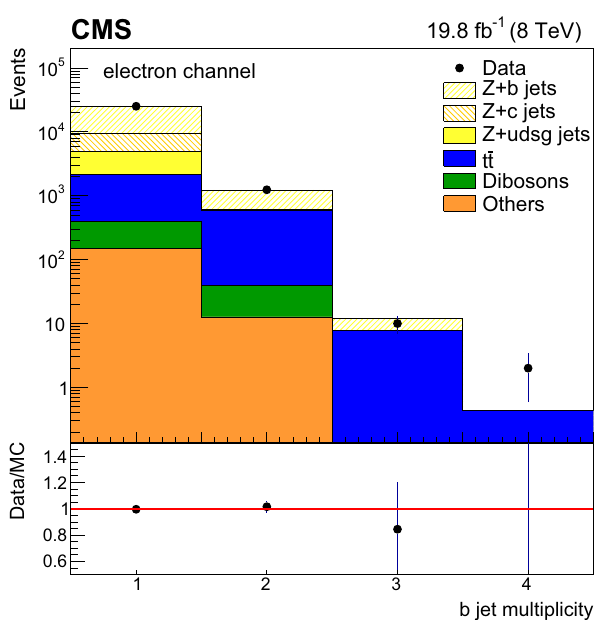
Fig. 1 Exclusive b-tagged jet multiplicity distributions for Z ( 1b ) events,fortheelectron( left )andmuon( right )decaychannelofZ boson. Error bars account for statistical uncertainties in data in the upper plots